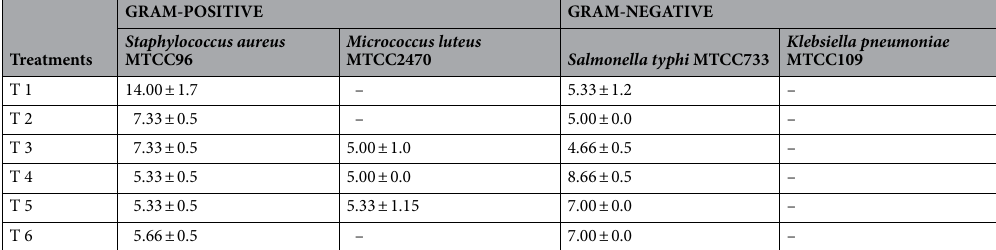
Table 5. Antibacterial activity of the R. officinalis essential oils on Gram-positive and Gram-negative bacterial strains. Ampicillin (10 µg disc -1 ) and streptomycin (10 µg disc -1 ) were used as positive controls against Gram- positive and Gram-negative bacteria, respectively; Values are means ± Standard Deviation (SD) of triplicate readings expressed in mm including 6 mm of well diameter. T1: Rainy season IHBT/RMAc-1; T2: Rainy season IHBT/RMAc-2; T3: Autumn season IHBT/RMAc-1; T4: Autumn season IHBT/RMAc-2; T5: Summer season IHBT/RMAc-1; T6: Summer season